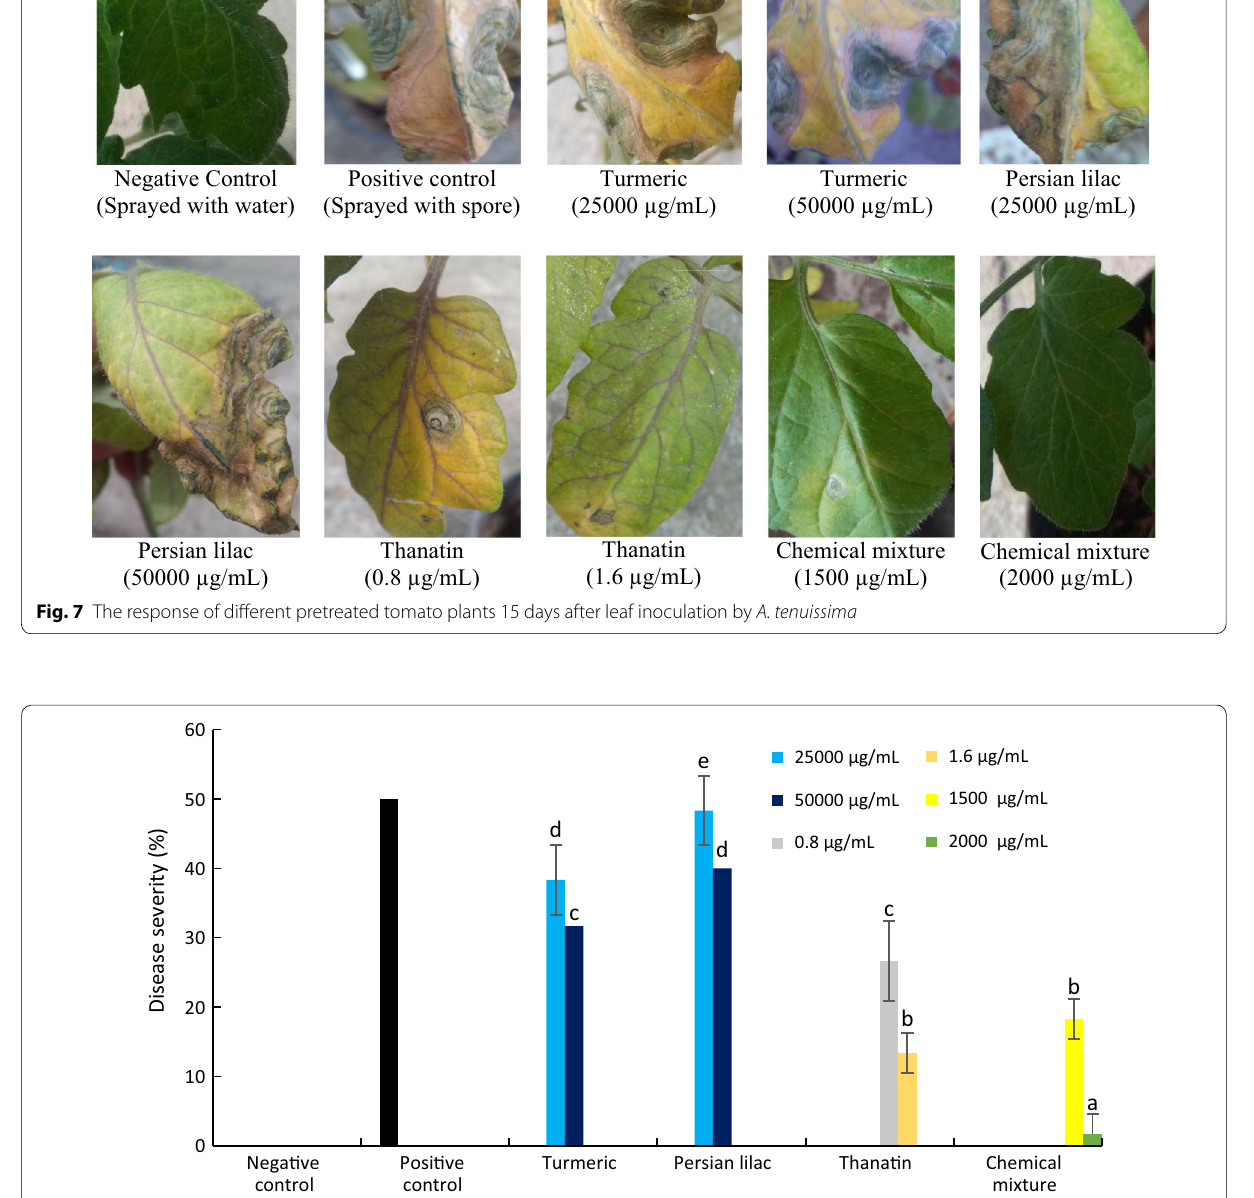
Additional file 1. Schematic representation of thanatin nucleotide and amino acid sequences.